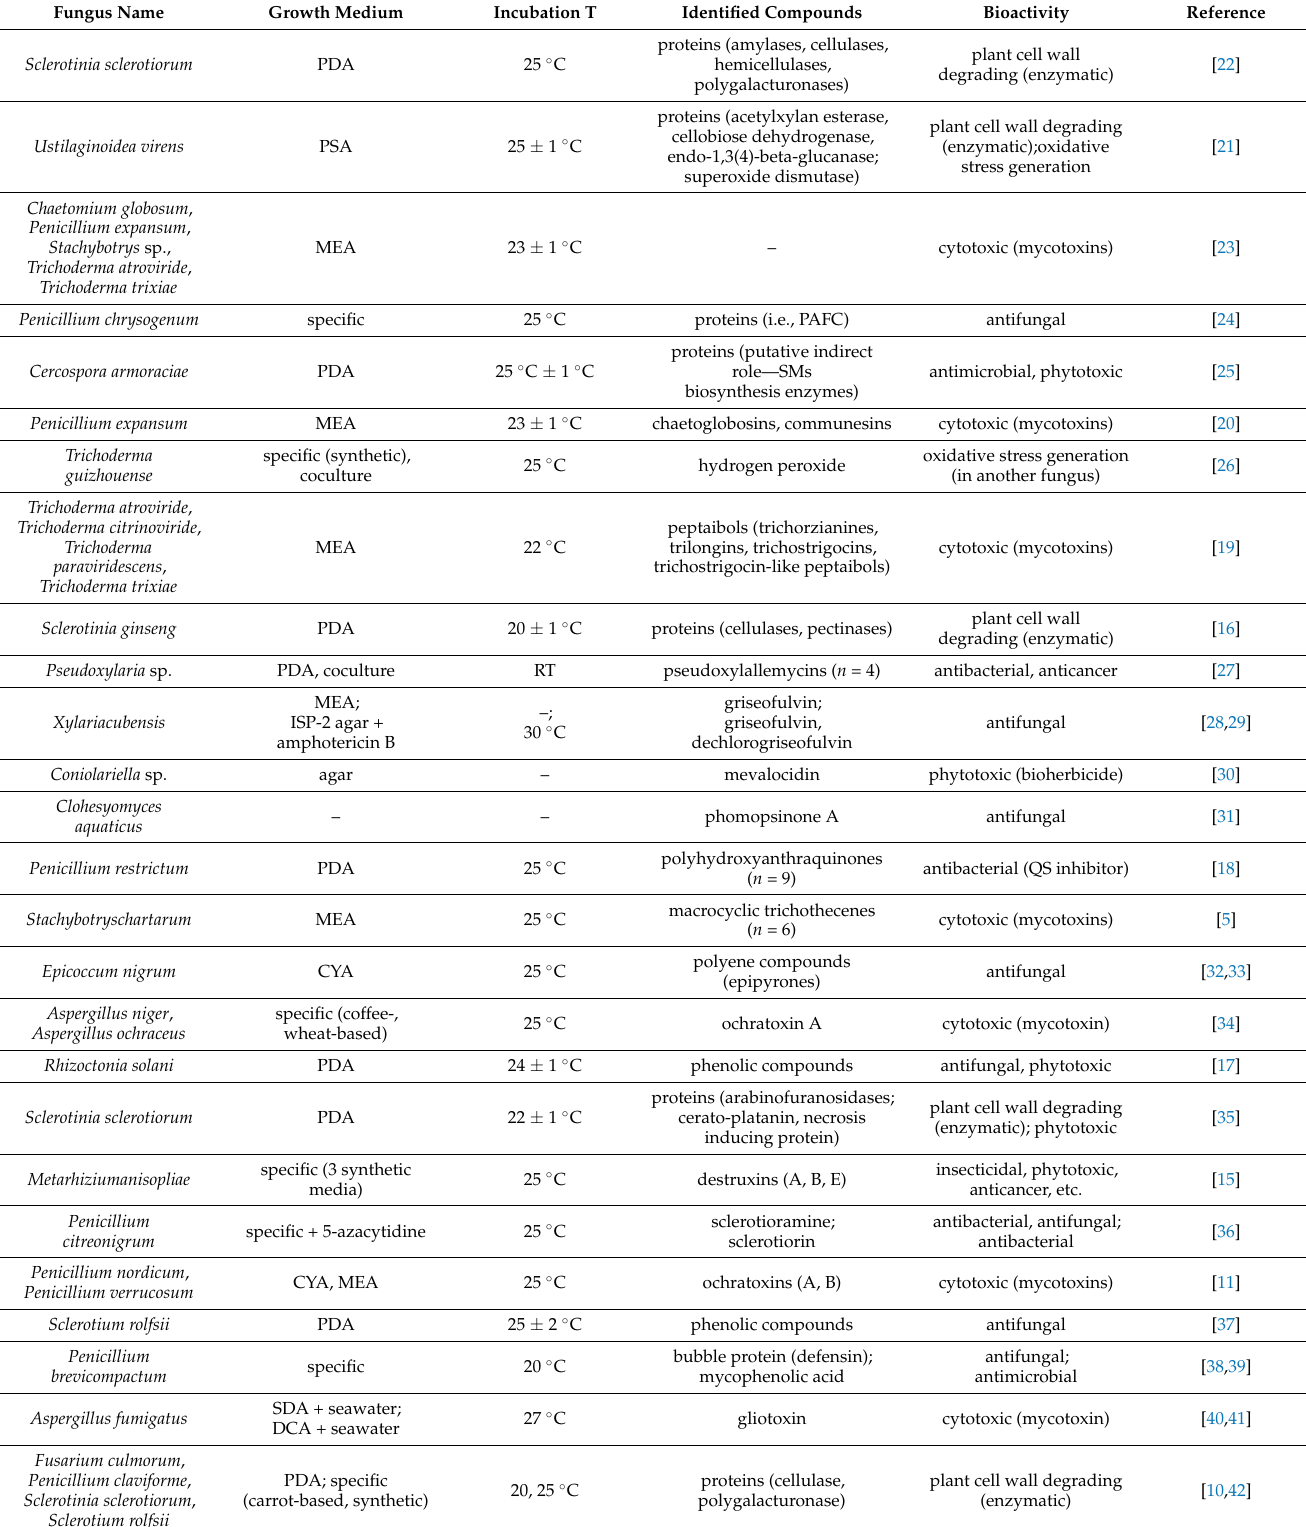
Table 1. Reports on bioactive compounds found in fungal exudates and culture conditions enabling